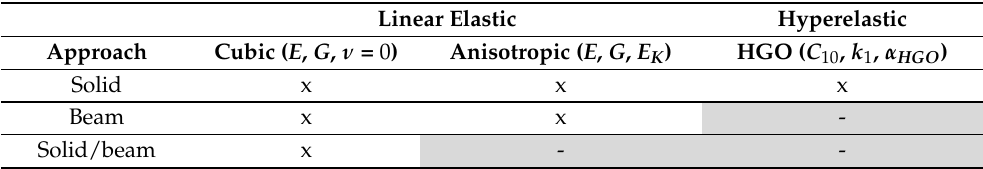
Table 2. Options of the efficient modeling approaches in terms of elements and material models